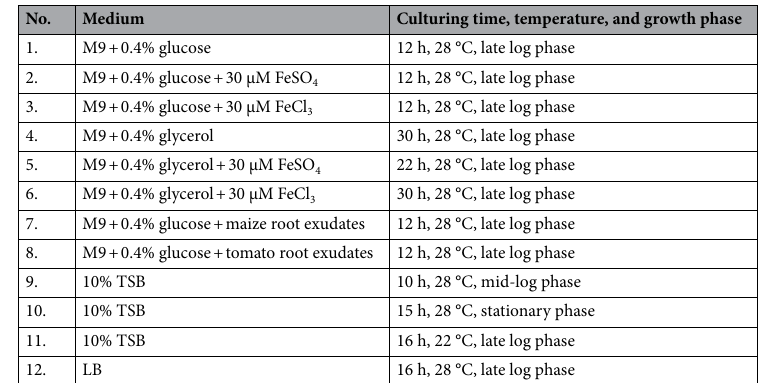
Table 2. Conditions of P. donghuensis P482 culture used in reference gene selection